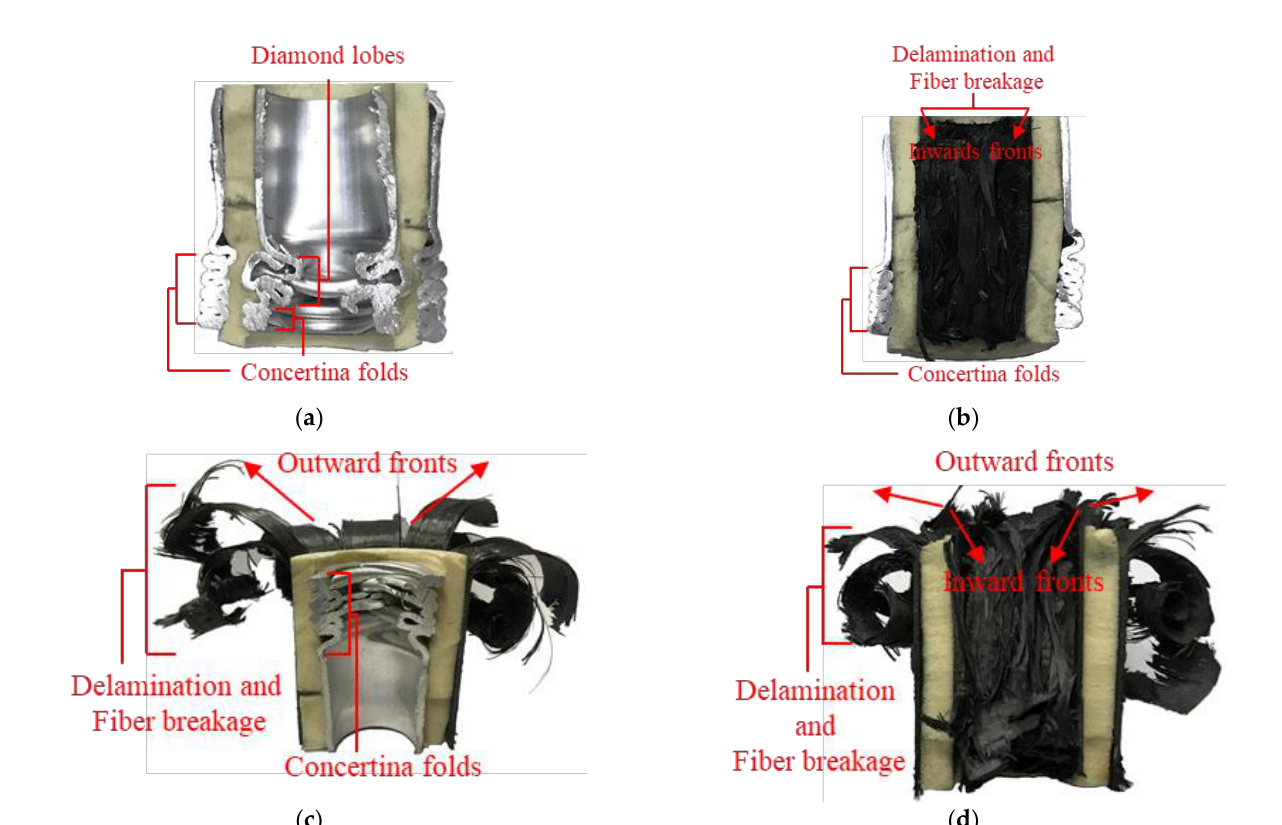
Figure 6. Deformation mode and force – displacement curves of hybrid structures: ( a ) AL-PU-AL; ( b ) AL-PU-C; ( c ) C-PU-AL; ( d ) C-PU-C.